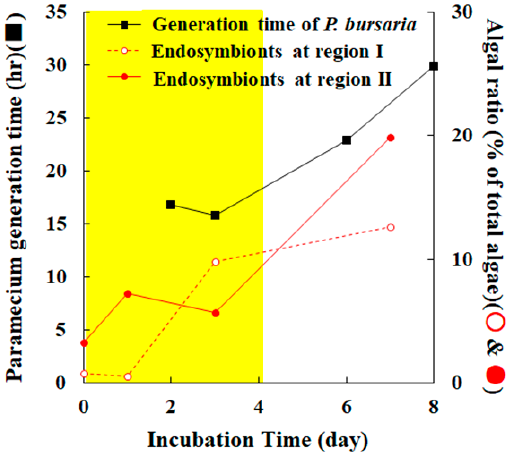
Figure 7. Entrainment of chronological behaviors between endosymbionts and their host paramecia. Host generation times (Figure 5E) and the chronological group dynamics of endosymbiotic algae in P. bursaria (Figure 6C) were compared. Yellow and white areas in the graph respectively represent the duration for the exponential growth phase and the initial stationary phase of P. bursaria . The figure was referred from the literature